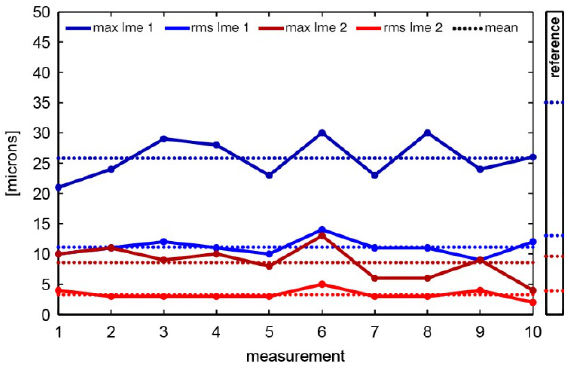
Figure 13. Quality characteristics (systematic pattern and distance-dependent